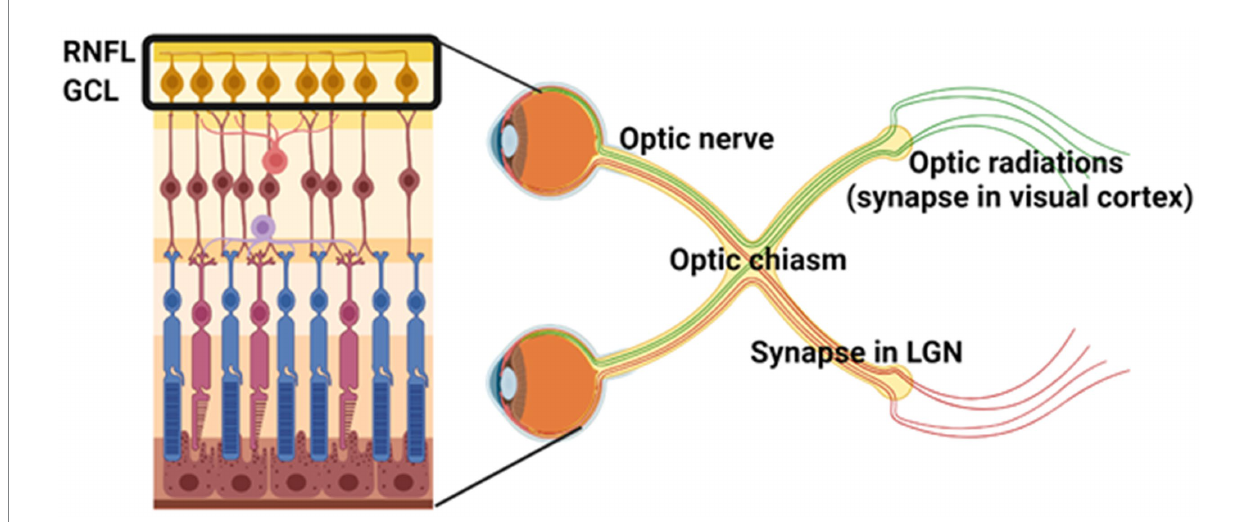
FIGURE 1 Organization of the anterior and posterior visual pathways. Retinal ganglion cells (RGCs) in the ganglion cell layer (GCL) are the innermost neurons of the retina. RGC axons comprise the unmyelinated retinal nerve fiber layer (RNFL) and become myelinated in the optic nerve. Optic nerve axons form presynaptic terminals in the lateral geniculate nucleus (LGN) of the thalamus. Together, this forms the anterior visual pathway. The afferent fibers from the dLGN emerge as the optic radiations and innervate V1 in the occipital region of the brain to process vision, forming the posterior visual pathway. Image created with